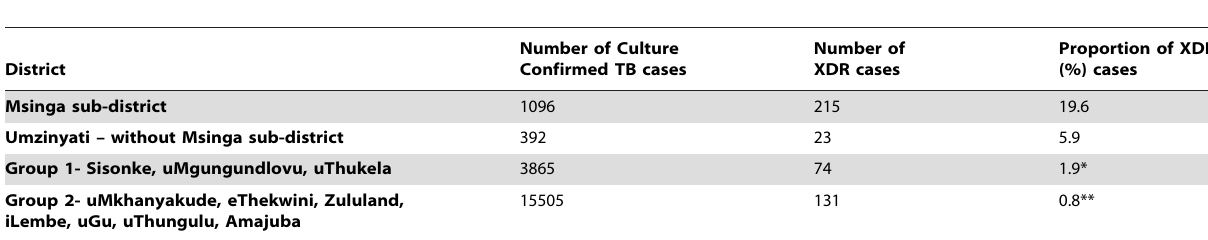
Table 3. Health districts according to proportion of culture-confirmed XDR tuberculosis.